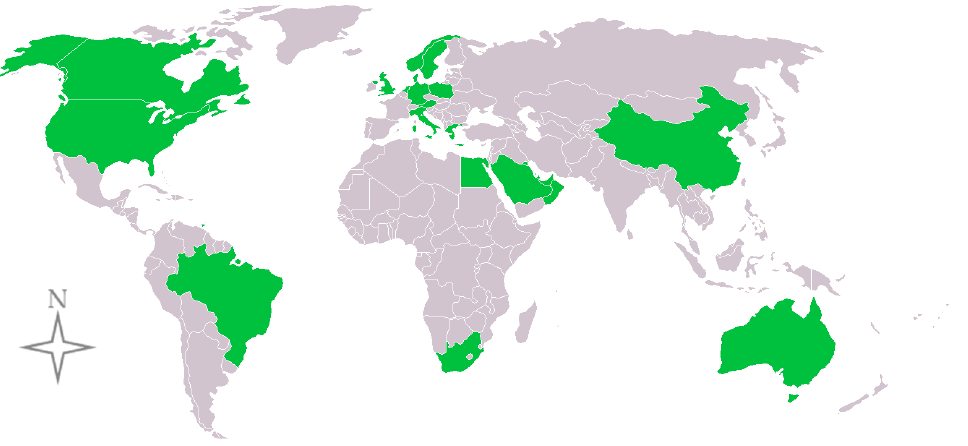
Figure 1. Geographical distribution of the evaluated studies: the green color shows the countries in which studies were carried out (map scale 1:220.000.000).